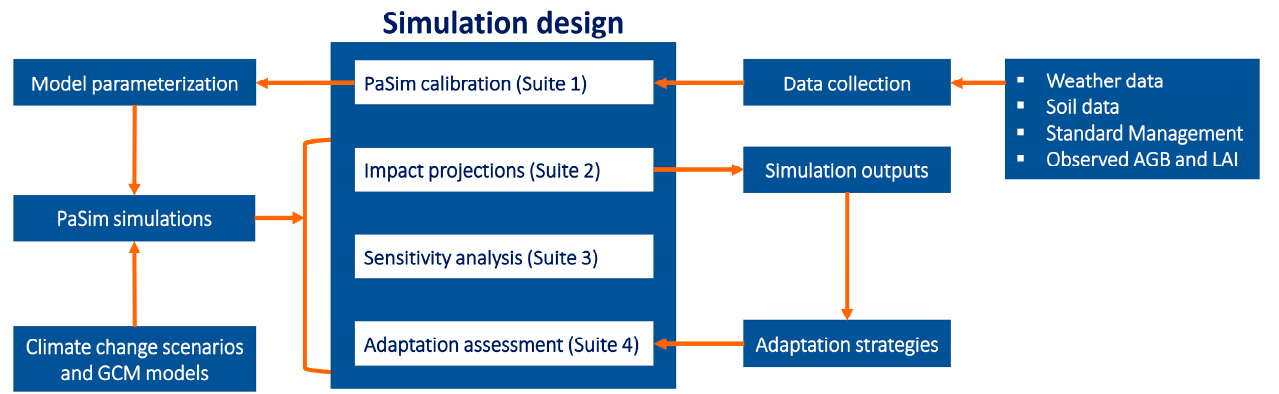
Figure 1. Workflow of the methodology applied in this study. PaSim is the grassland simulation model used for the analysis.